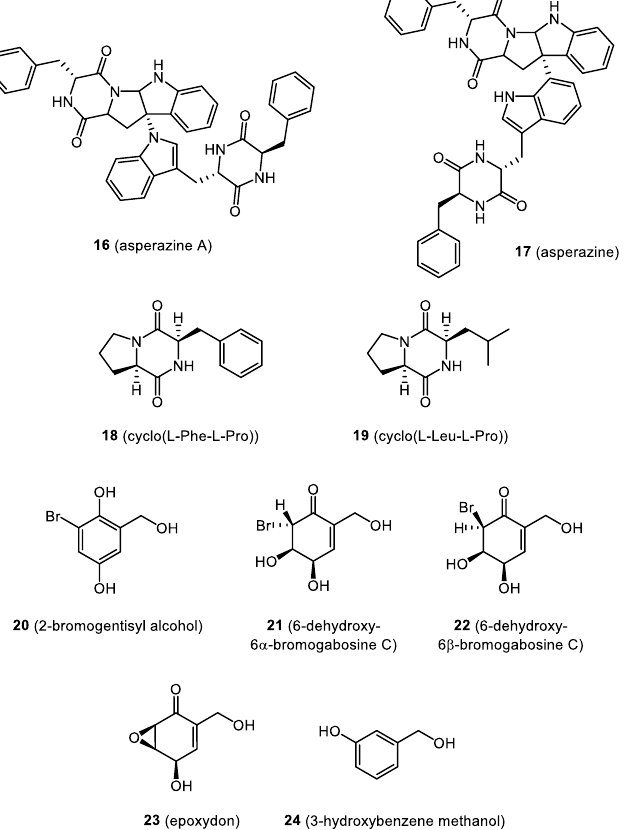
Figure 5. Bryendophyte metabolites ( 16 – 24 ) with cytotoxic and anticancer activities.